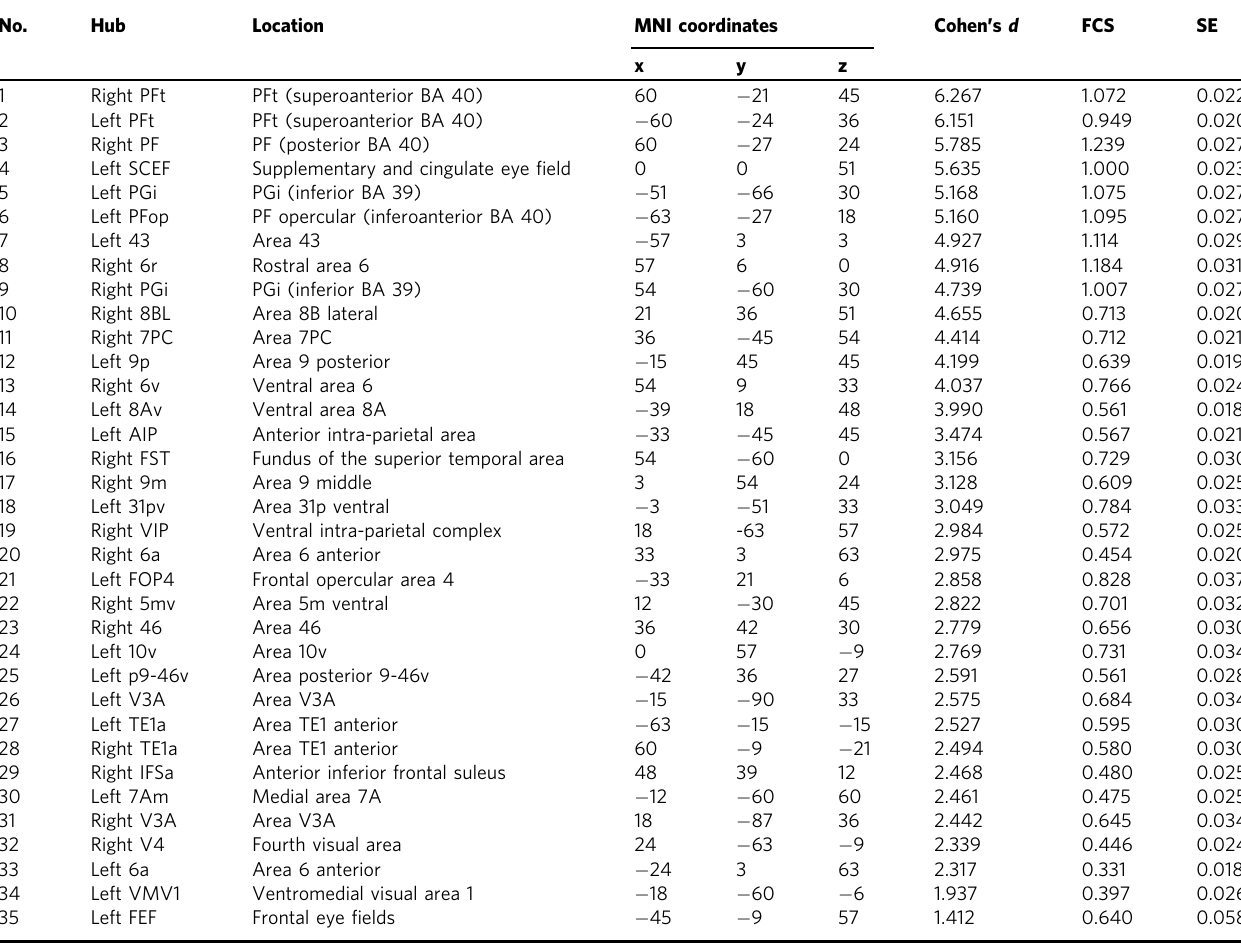
Table 1 Highly consistent functional connectome